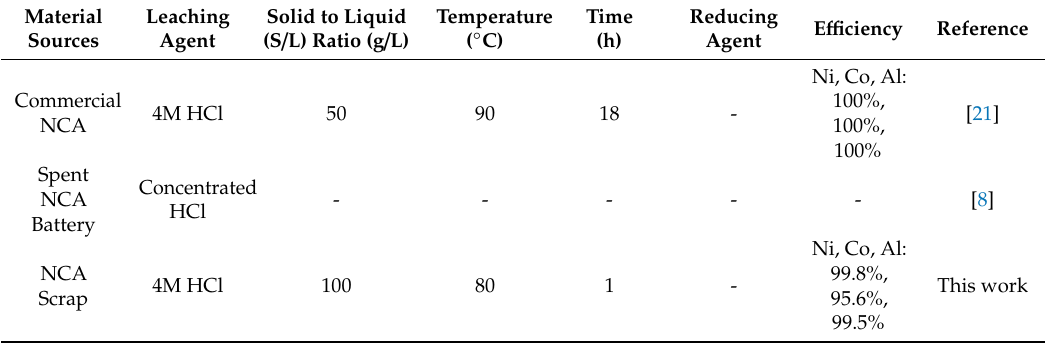
Table 1. Summary of leaching conditions used in metal recovery from NCA using HCl from previous works and the present work.